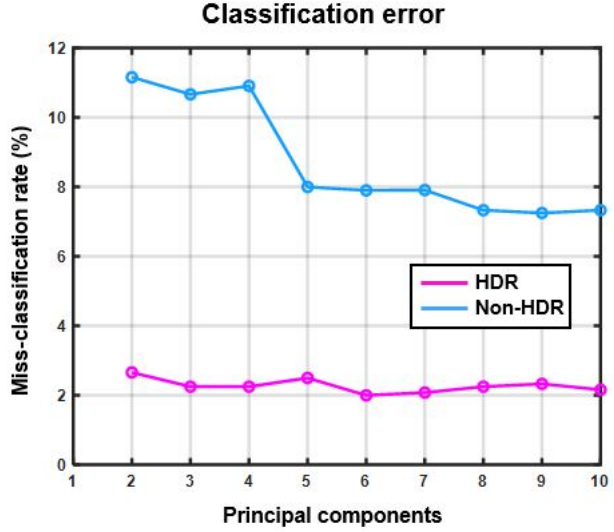
Figure 12. Miss-classification rate (%) vs. number of principal components (test case 1).